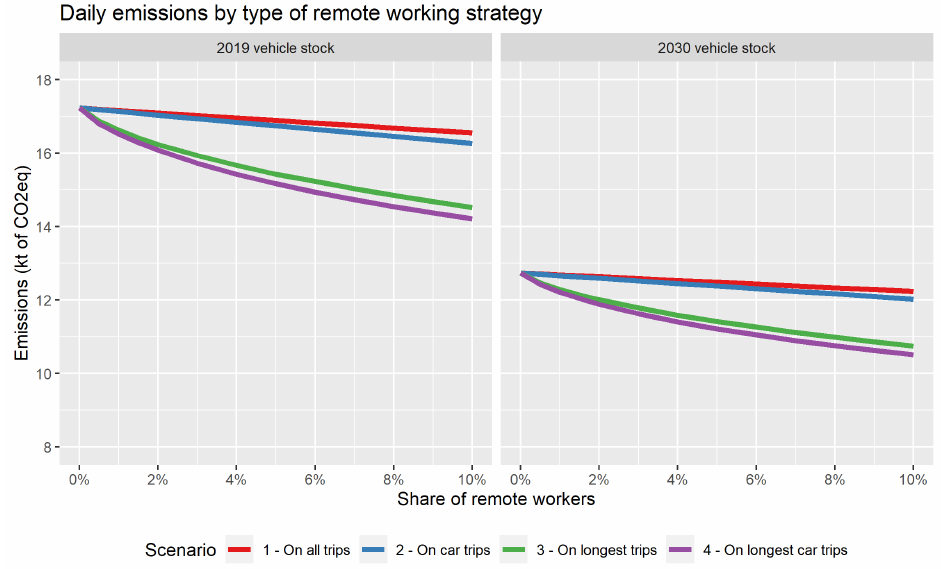
Figure 7. The effect of remote working on daily GHG emissions of passenger trips in Lombardy, by remote working